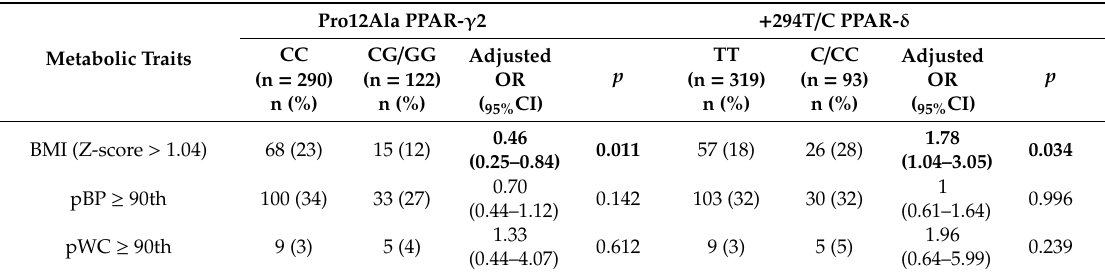
Table 8. Association between Pro12Ala PPAR- γ 2 or + 294T / C PPAR- δ with metabolic traits in the total studied